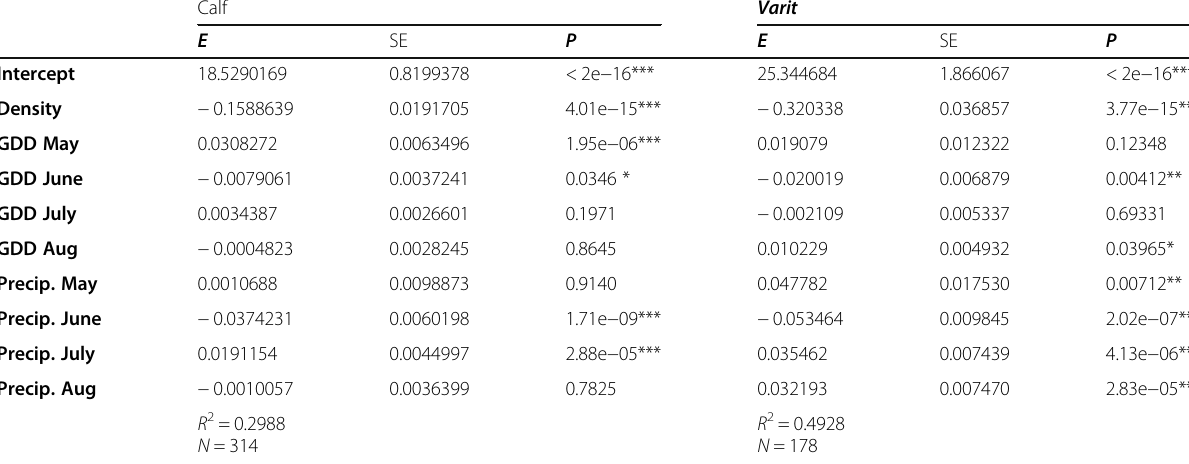
Table 1 Ordinary least squares (OLS) multiple linear regressions of varit and calf carcass weights for mainland districts Calf